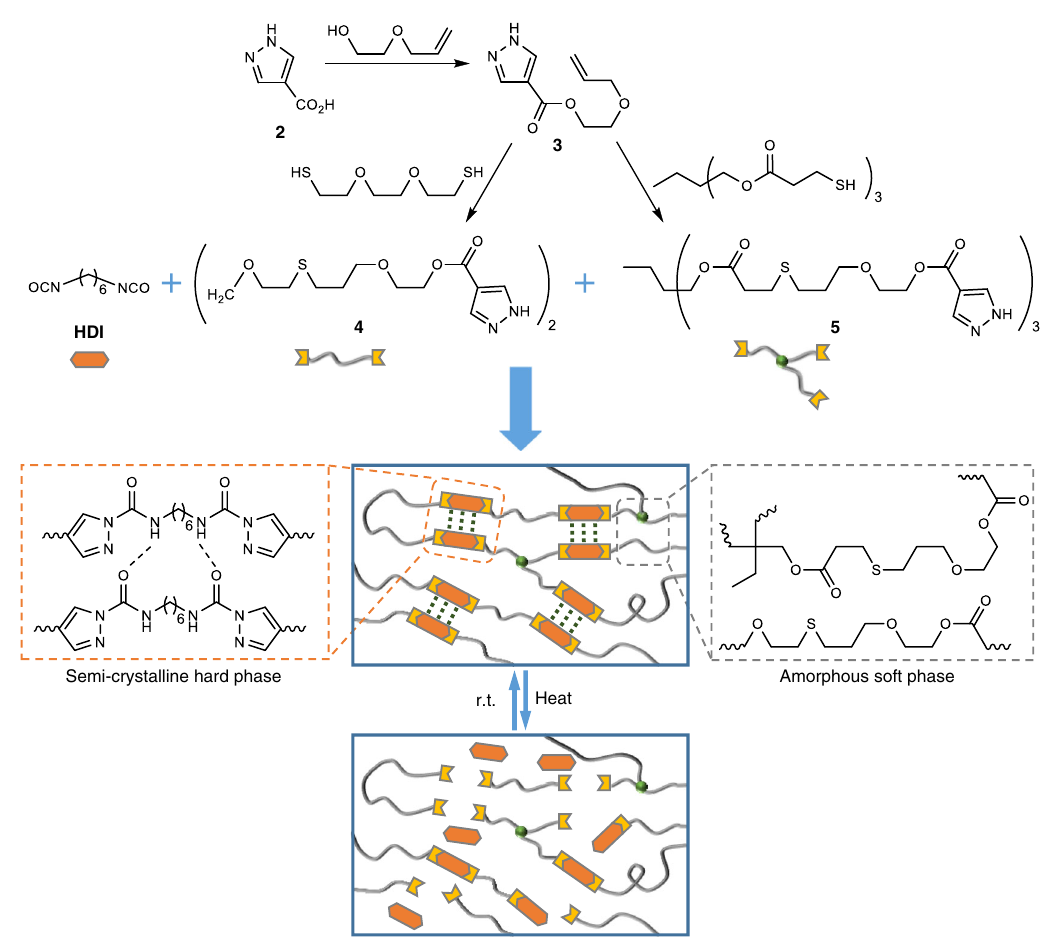
Fig. 3 Design and synthesis of dynamic multiphase poly(pyrazole –